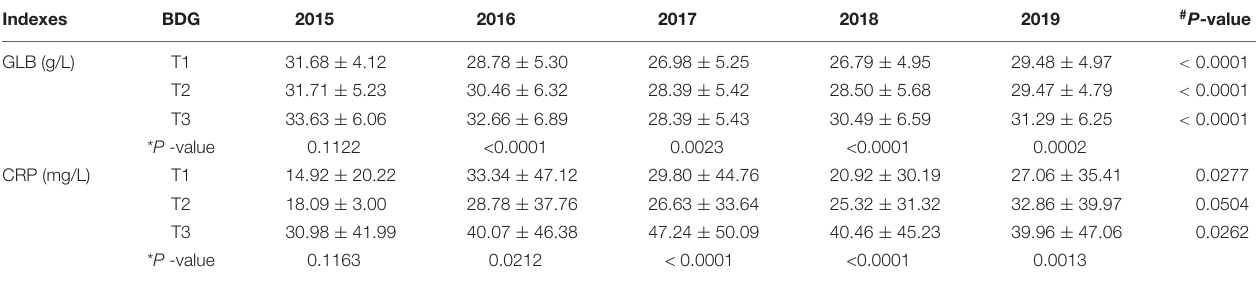
TABLE 3 | The changes of globulin (GLB) and C-reactive protein (CRP) concentration between the follow-up years according to BDG concentration. Indexes